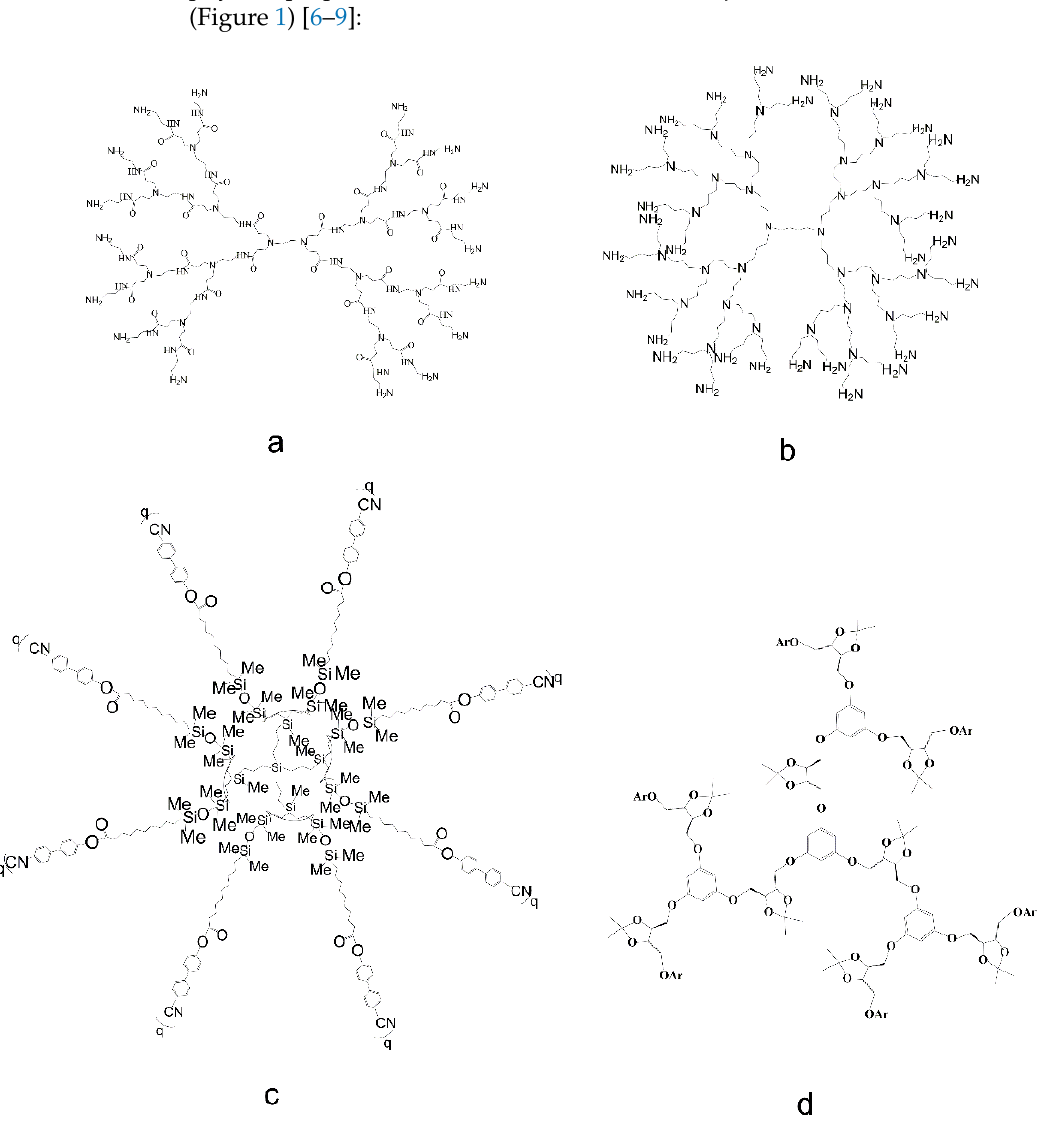
Figure 1. The structures of four major monomeric dendrimers: ( a ) Poly (amidoamine); ( b ) Poly (propylene imine); ( c ) Carbosilane; ( d ) Chiral dendrimers. Poly (Amidoamine) (PAMAM)